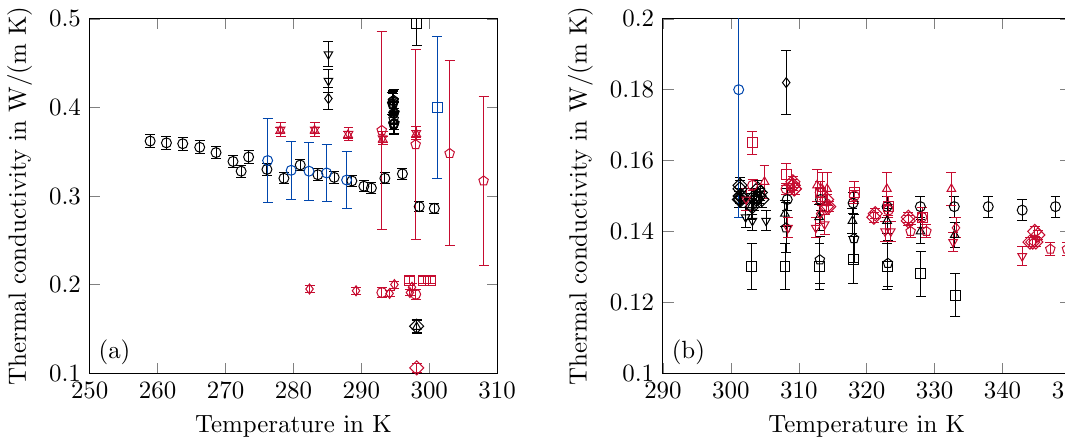
Figure 4. Summary of thermal conductivity data from the literature in the solid ( a ) and liquid ( b ) state. The error bars are the specified uncertainty of the data. ( a ) ◦ [27] (cid:3) [32] (cid:5) [38] ∆ [39] (cid:79) [80] ♦